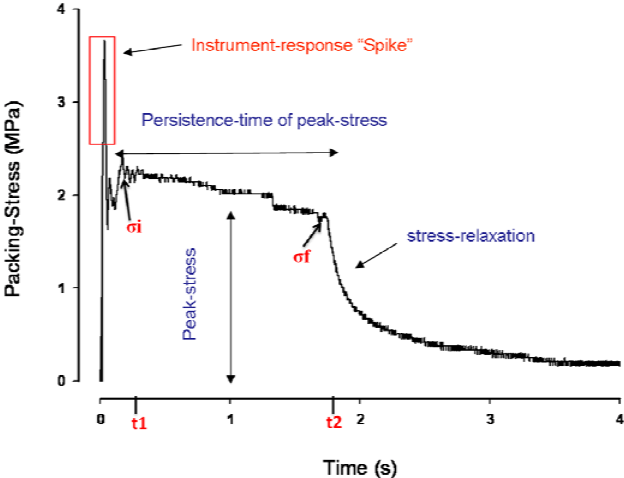
Figure 1. Time dependant packing stress profile